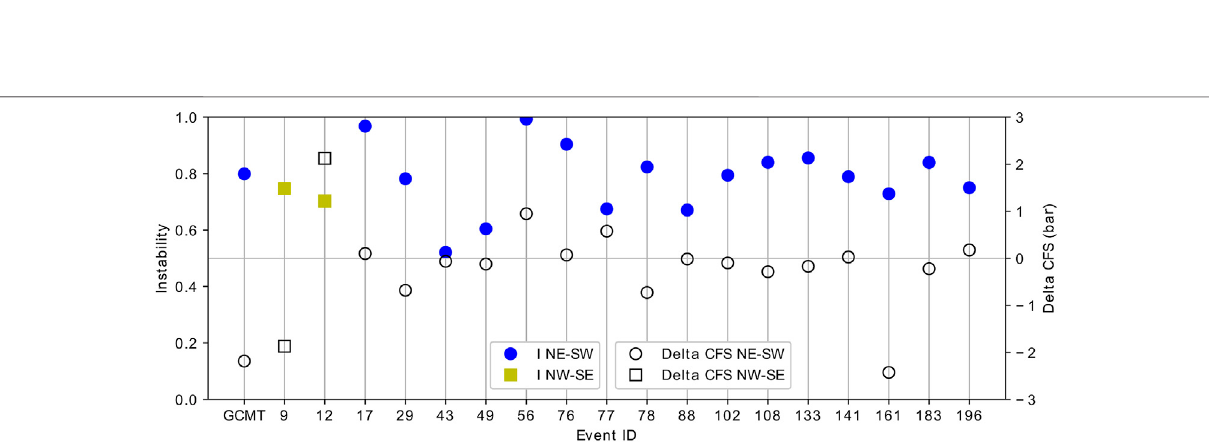
Frontiers in Earth Science |